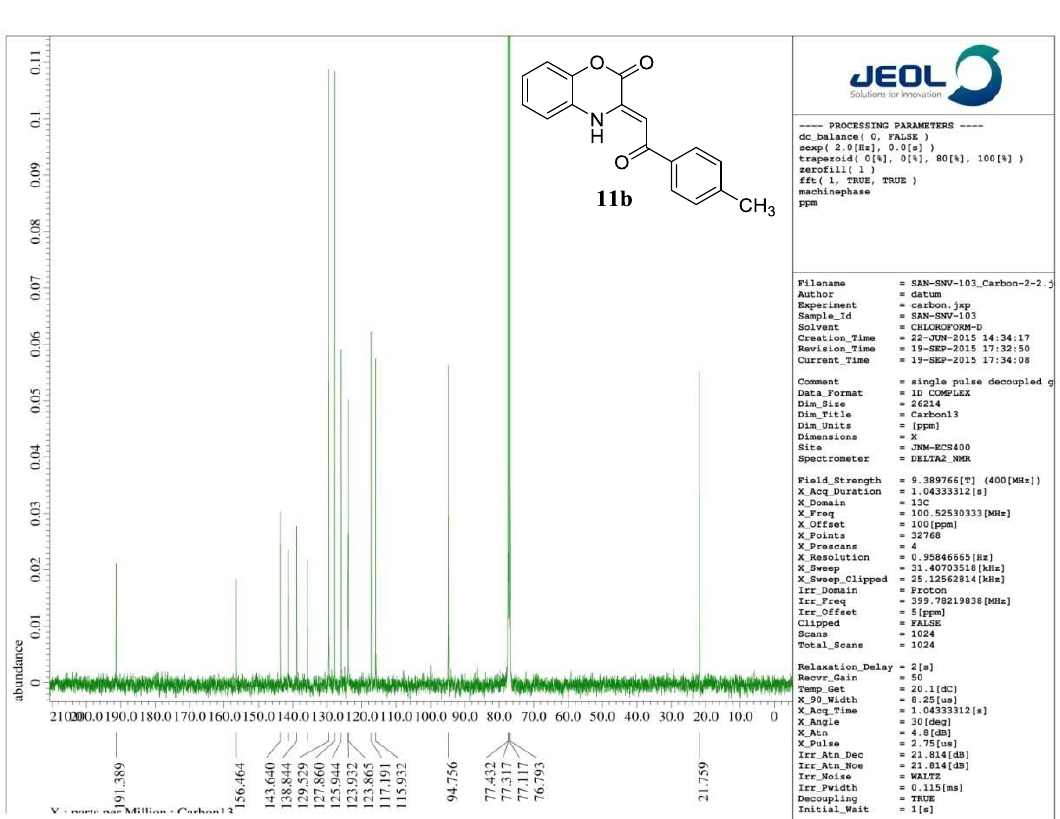
Figure 4. 1 H NMR Spectra of Compound 11b